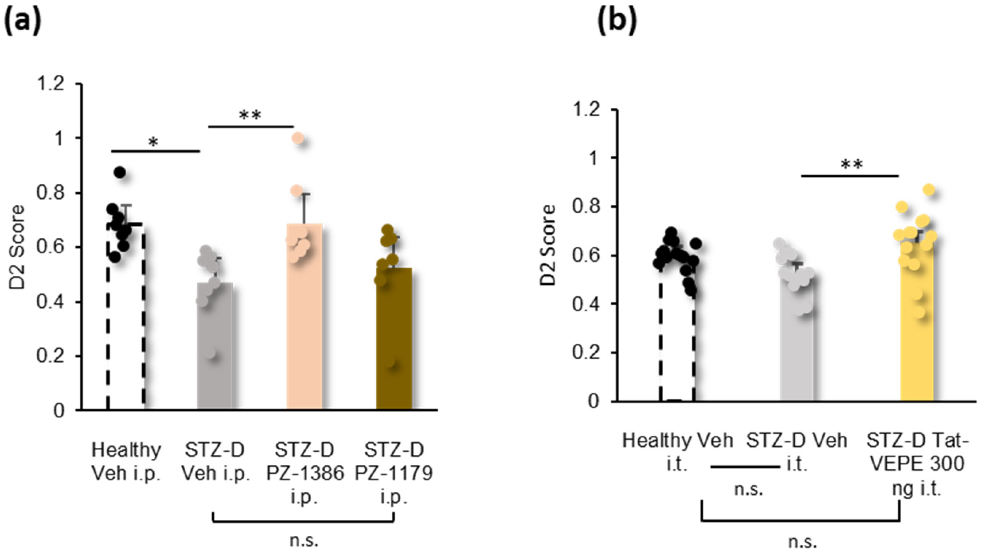
Figure 4. Intrathecal administration of Tat-VEPE attenuates mechanical hyperalgesia (paw pressure test) in STZ diabetic rats. ( a ) Intrathecal administration of a cell-permeable interfering peptide fused to the transduction domain of the HIV Tat protein (Tat-VEPE, 300 ng/rat) increases the vocalization threshold to paw pressure application in STZ-D rats ( n = 6–7 /group). ### p < 0.001 vs. values measured before STZ. ** p < 0.01, *** p < 0.001 vs. values measured before the drug/vehicle injection (D21 Post-STZ), 2-way ANOVA; ( b ) Area under the curve (A.U.C.) of vocalization threshold variations in STZ rats calculated by the trapezoidal rule (in a.u. min). ** p < 0.01 vs. Vehicle group; ## p < 0.01 vs. corresponding group, 1-way ANOVA.